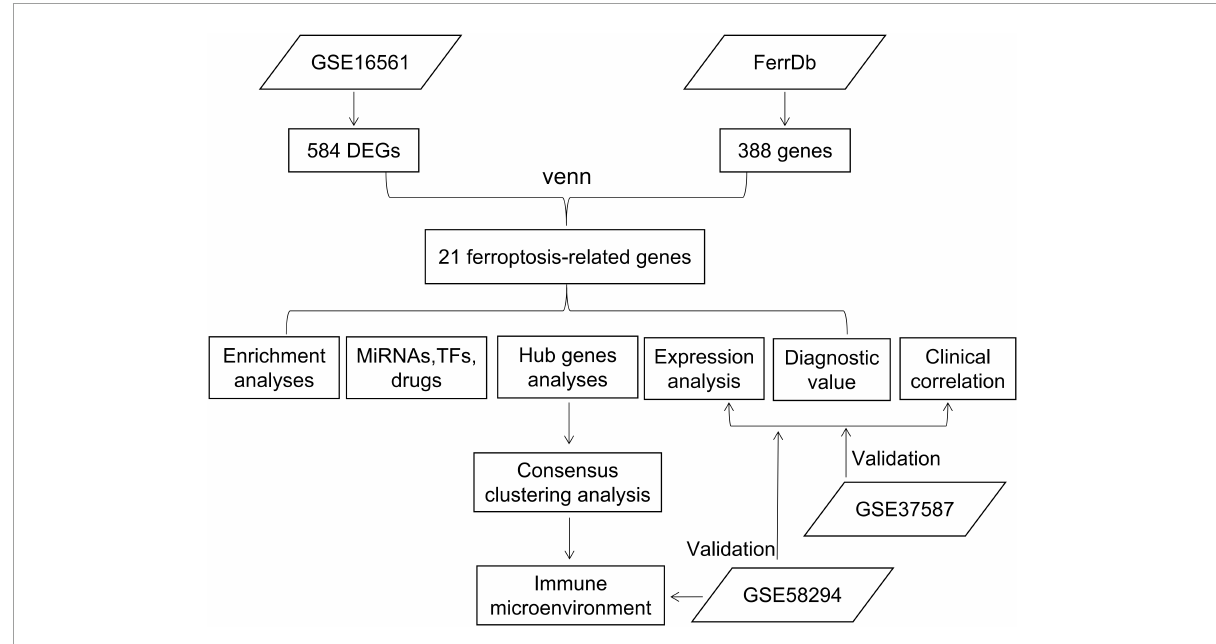
FIGURE1 Workflow chart. DEGs, differentially expressed genes; TFs, transcriptional